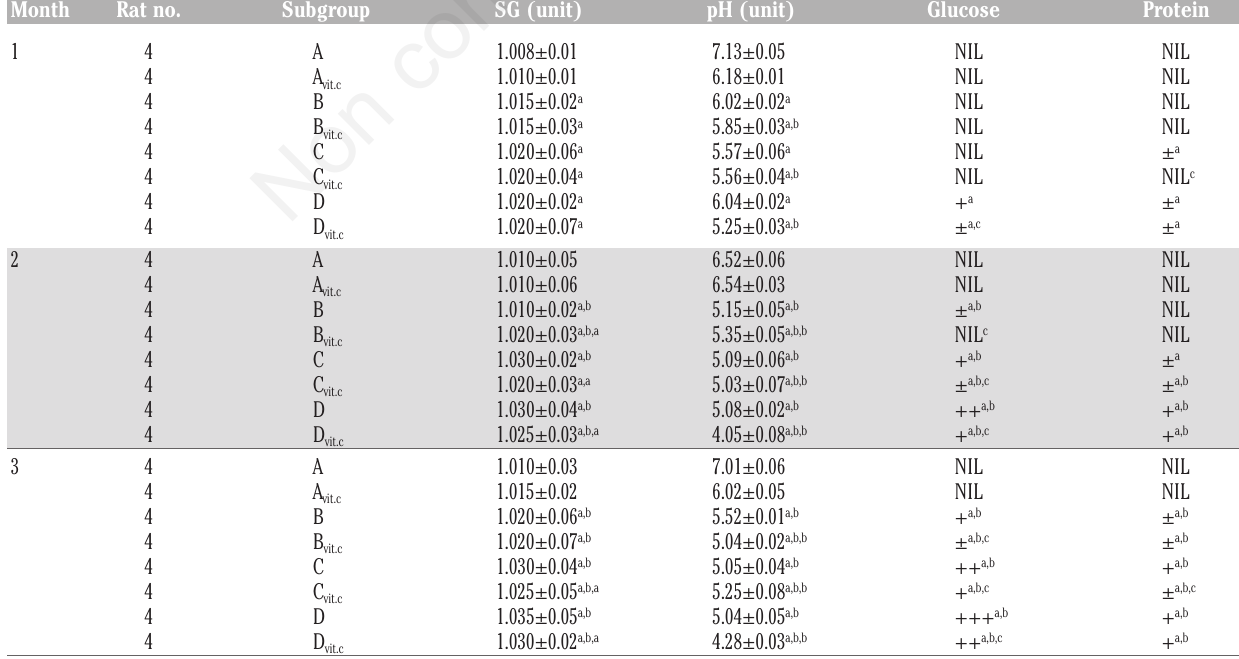
Table 2. Mean urine specific gravity, pH, glucose and protein results obtained during study period. Month Rat